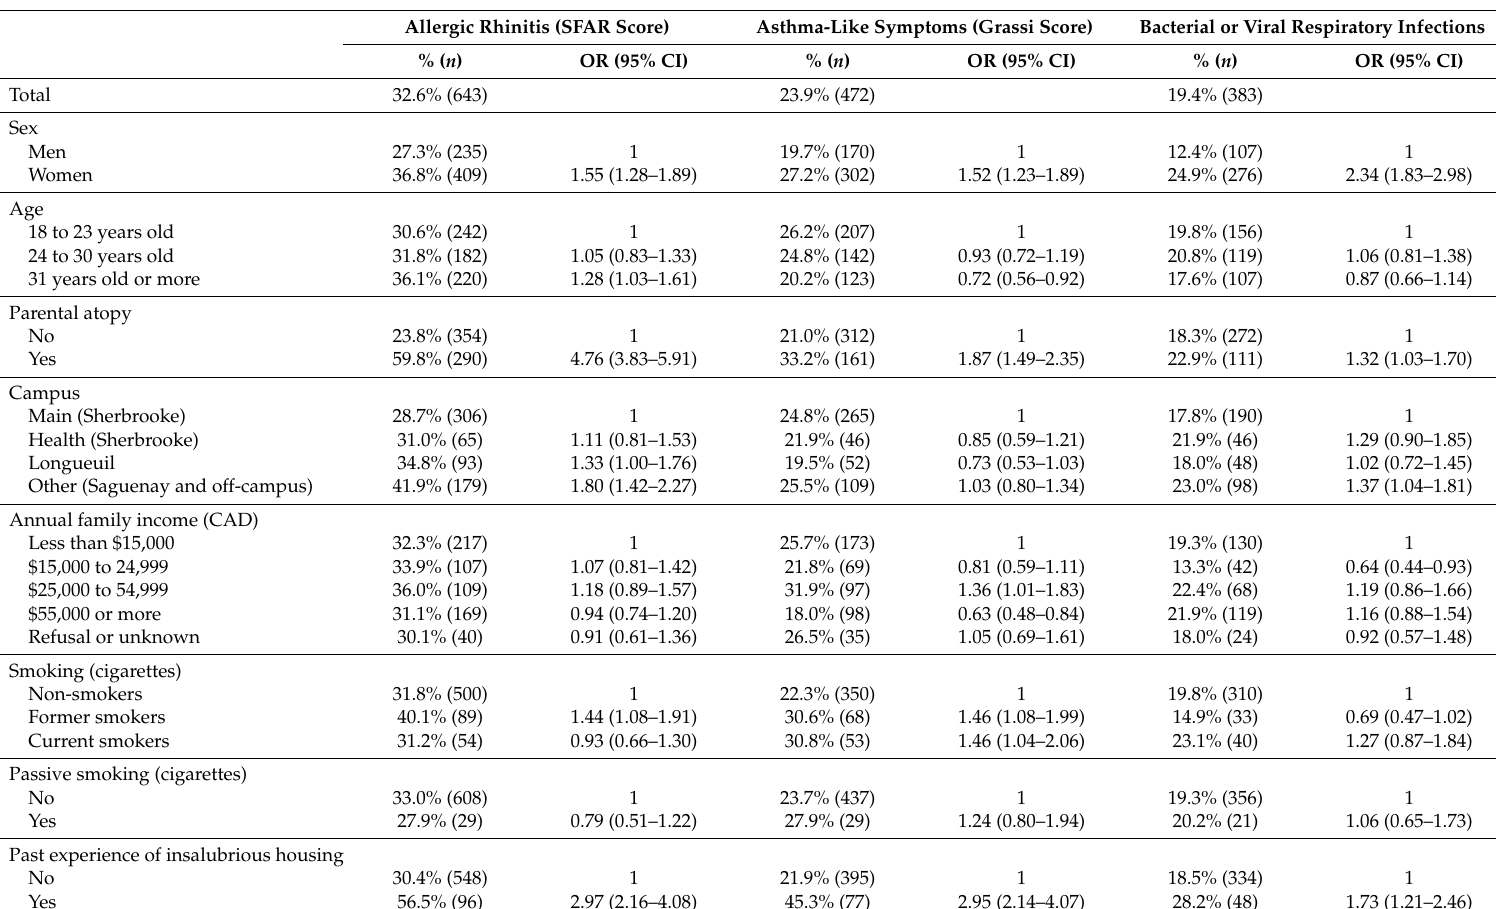
Table 2. Prevalence 1 of self-reported respiratory diseases (in the last 12 months) among university students according to student characteristics (weighted data, n =